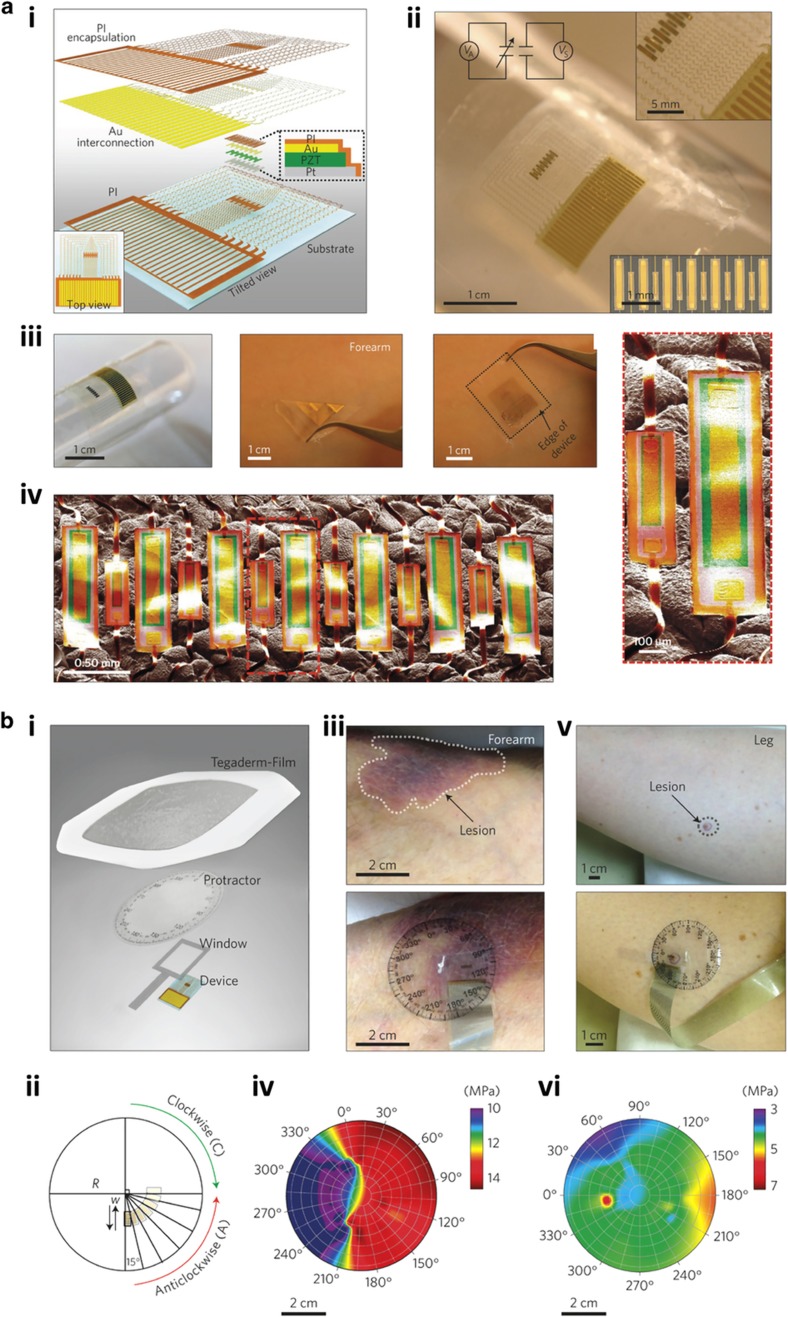
Flexible and stretchable physical sensing platforms for physiological monitoring and assessment. (a) Soft piezoelectric compliant modulus sensor (CMS) constructed from the flexible networks of mechanical sensors and actuators based on lead zirconate titanate nanoribbons. (i) Schematic illustration showing the exploded view of the device architecture: the top view of the device is shown in the lower-left inset, whereas the cross-sectional view of the device is depicted in the black-dashed region. (ii) Optical image showing the actual fabricated device on a thin silicone substrate. Scale bar 1 cm. Insets show the gold interconnection region (upper right, scale bar, 5 mm) and the arrays of sensors and actuators (lower-right, scale bar 1 mm) with the corresponding electrical circuit diagram (upper left). (iii) Optical images of a device conformed onto a cylindrical glass (left) and a device laminated partially (center) and fully (right) on the skin. Scale bars 1 cm. (iv) SEM image showing a CMS unit consisting of an array of six sensors and seven actuators on an artificial skin (scale bar 0.5 mm) with the corresponding magnified image of the red-dashed region depicting a sensor (left) and actuator (right) pair (scale bar, 100 μm). (b) Spatiodirectional mapping capability of the rotatable CMS unit and in vivo ‘on patient’ assessment. (i) Schematic illustration showing the exploded view of the rotatable CMS unit. (ii) Diagram illustrating the spatiodirectional mapping principle of the device, where R defines the protractor radius, and w defines the distance between the protractor center and the first sensor edge in the array that describes the mapping region. (iii) Optical image showing the forearm in the absence (top) and presence (bottom) of the mounted device. (iv) Mapping data corresponding to the assessment in (iii). (v) Optical image showing the lower leg in the absence (top) and presence (bottom) of the mounted device. (vi) Mapping data corresponding to the assessment in (v). Adapted with permission from Ref. 47. Copyright 2015 Macmillan Publishers Limited.